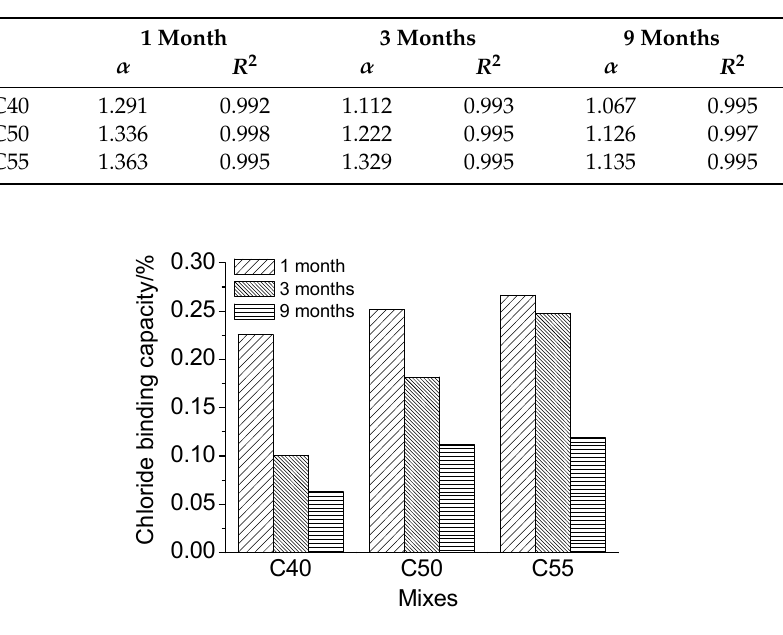
Figure 11. Chloride binding capacity of C40, C50, and C55 exposed to the atmosphere zone after ff erent different times. di